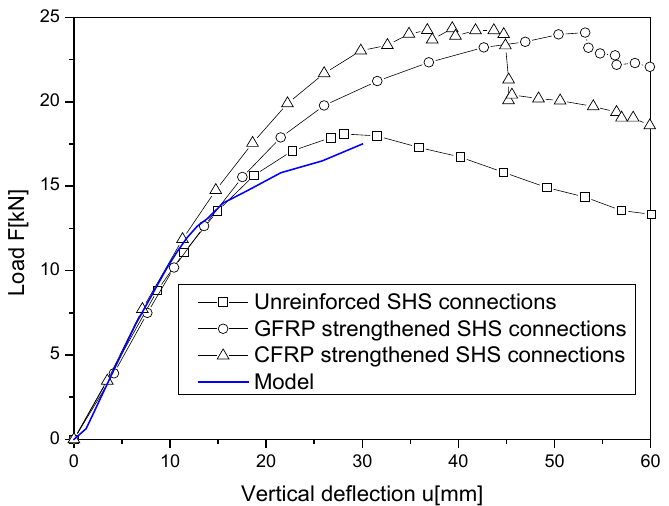
Figure 5. Force displacement curves for the connection under static loading . and the von Mises stress at a